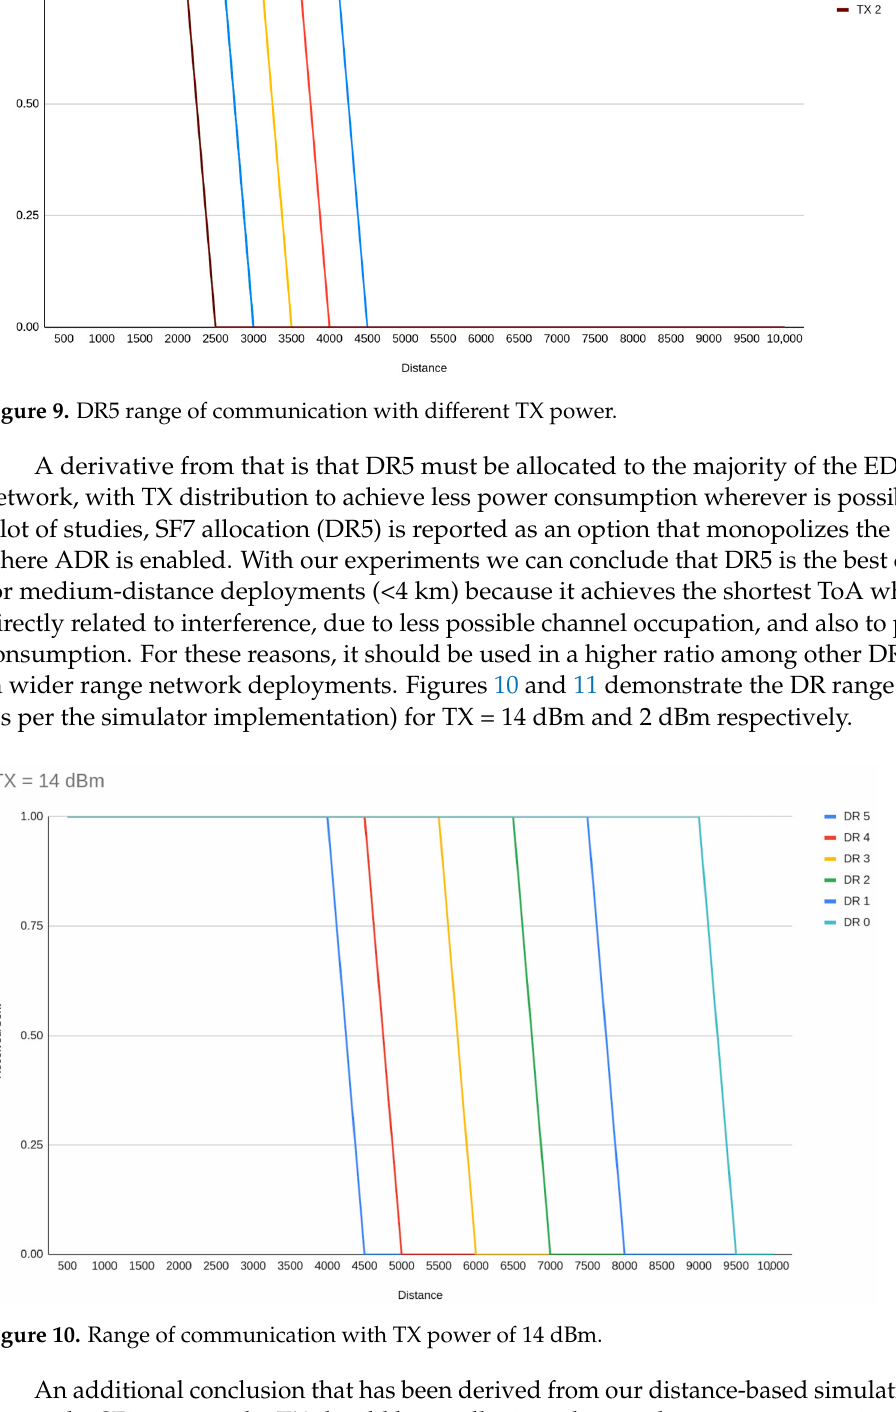
Figure 10. Range of communication with TX power of 14 dBm.